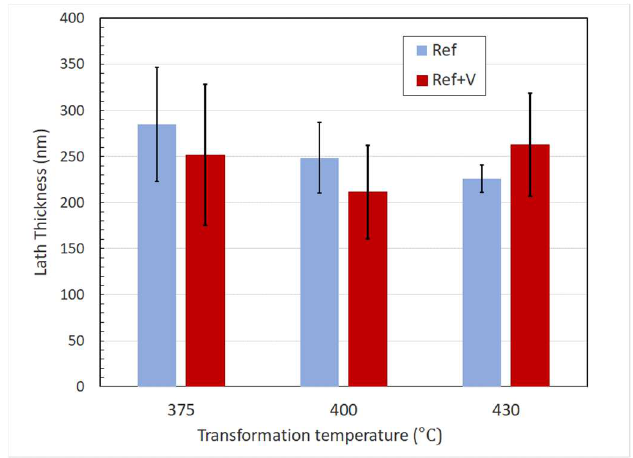
Figure 7. STEM measurement of bainite lath widths.